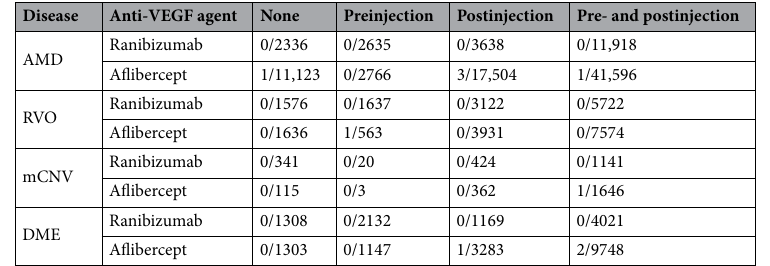
Table 3. The incidence of endophthalmitis in patients with the four diseases.